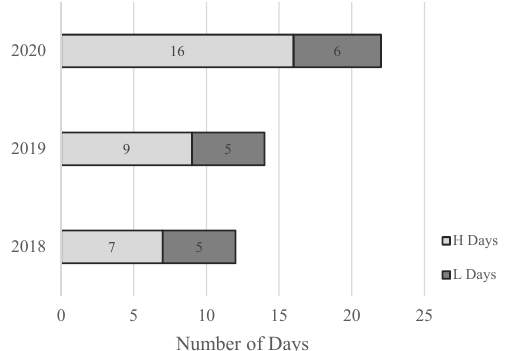
Figure 7. Number of days with maximum temperatures above 30 degrees Celsius (H Days) and below 30 degrees Celsius (L Days) for August 2018 to 2020 and defined as sea breeze days.